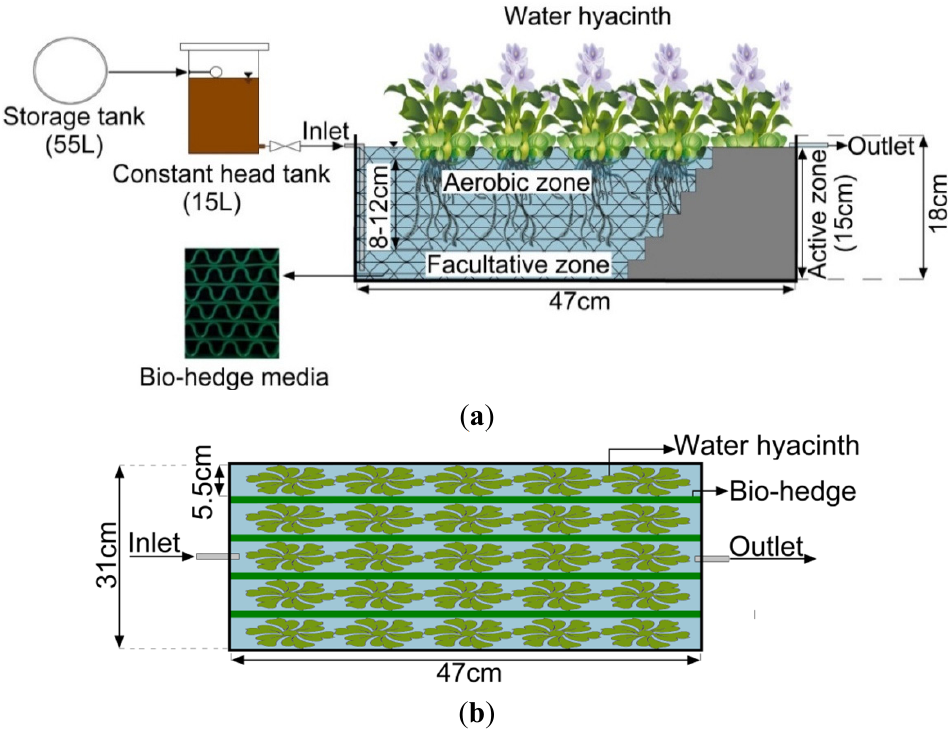
Figure 1. Schematic diagram of the Bio-hedge water hyacinth phytoremediation system: ( a ) cross section view; ( b ) plan